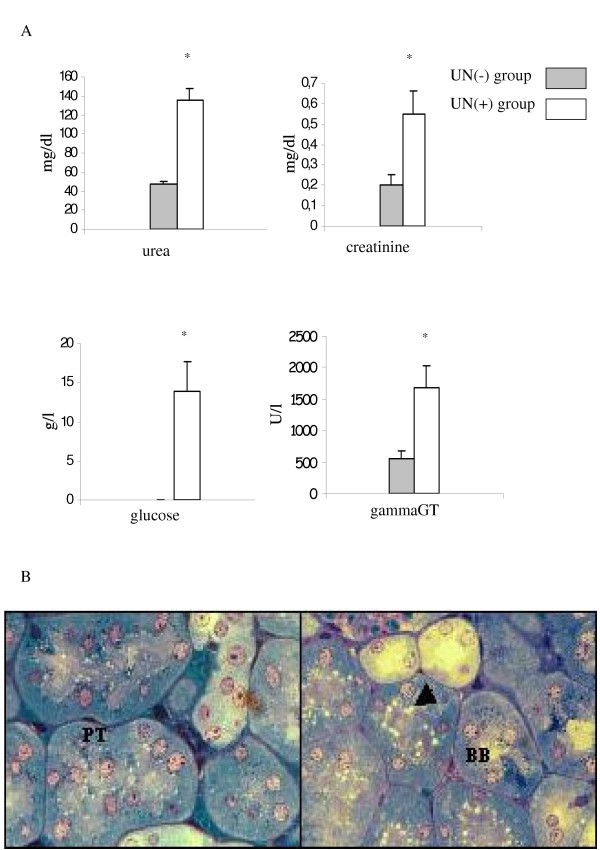
Characterization of UN-induced ARF. (A) Influence of UN on renal function. Blood levels of urea and creatinine and urinary levels of glucose and γGT are plotted. The bars represent the mean ± SEM. *p < 0.05 vs control. (B) Light micrographs of renal tissue from UN(-) (left panel) and UN(+) (right panel) group given 5 mg/kg UN intraperitoneally. Proximal tubules (PT), sectioned transversely, are lined by high cuboidal or pyramidal epithelium. A slight loss in the brush border (BB), and large vacuoles (arrow) in proximal tubular cells in comparison with control group are depicted (×40).